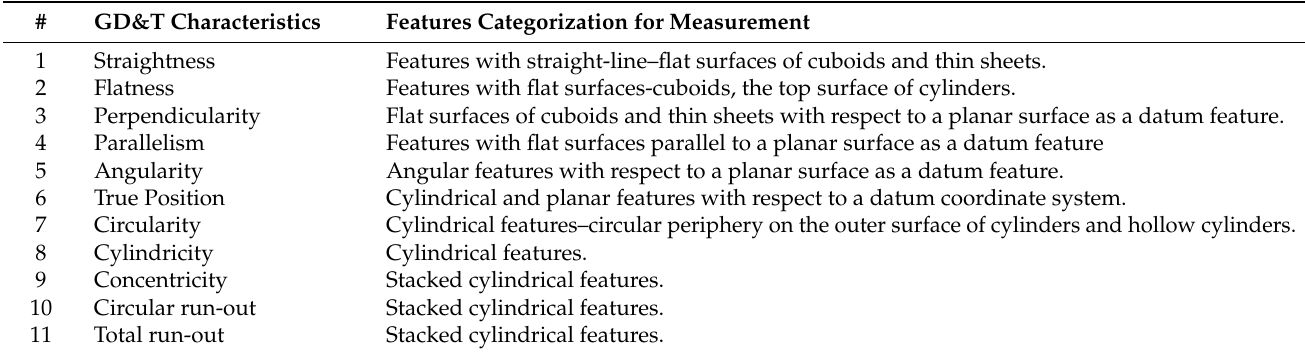
Table 3. Feature categorization for measurements based on GD&T characterization.